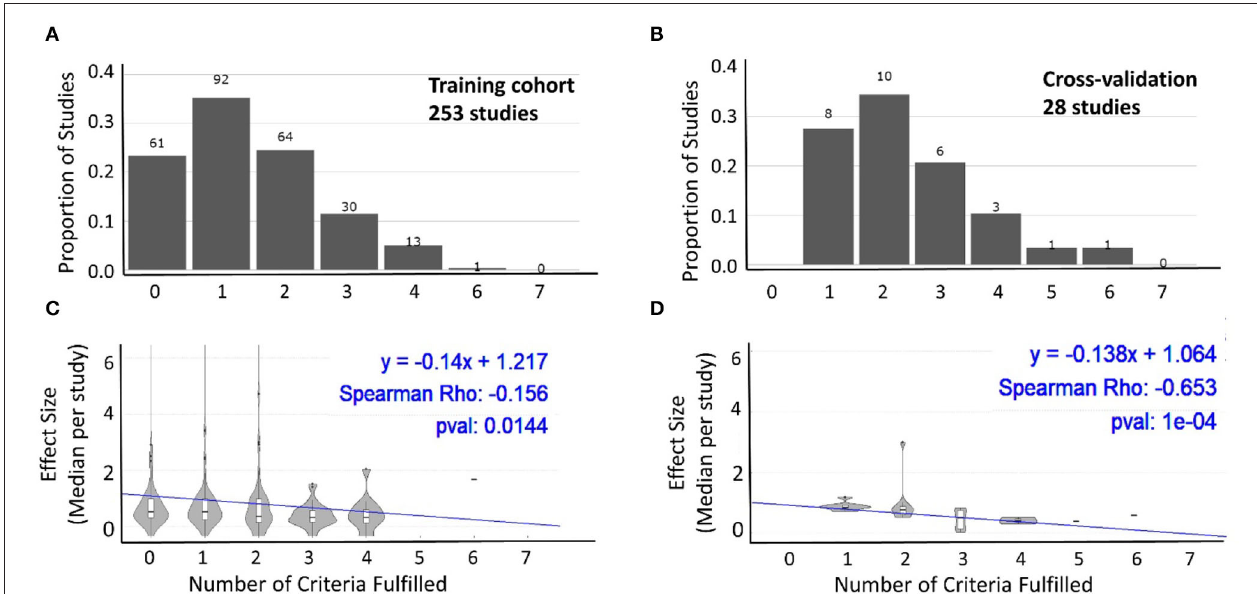
FIGURE 4 | Relationship between technical quality of the study and reported effect size. The proportion of studies fulfilling the sum of the seven technical quality criteria (zero weakest experimental design to seven strongest experimental design) for 253 studies with training cohorts (A) and cross-validation cohorts (B) . The number of studies in each category is listed above the bars. Effect sizes reported by studies categorized based on the number of technical quality criteria they fulfilled (0–7) for training cohort ( C ; n = 253) and cross-validation ( D ; n = 28) results. In both cohorts, the reported effect sizes decreased as the number of technical quality criteria fulfilled by these studies